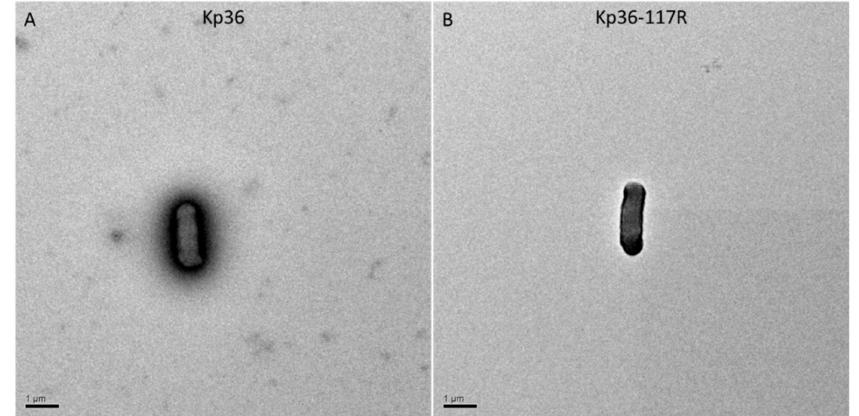
Figure 4. K. pneumoniae strains expressing di ff erent capsules were stained with phosphotungstic acid and were observed under a transmission electron microscope. ( A ) Kp36 (wild-type); ( B ) Kp36-117R (phage 117-resistant mutant). Scale bars, 1 µ